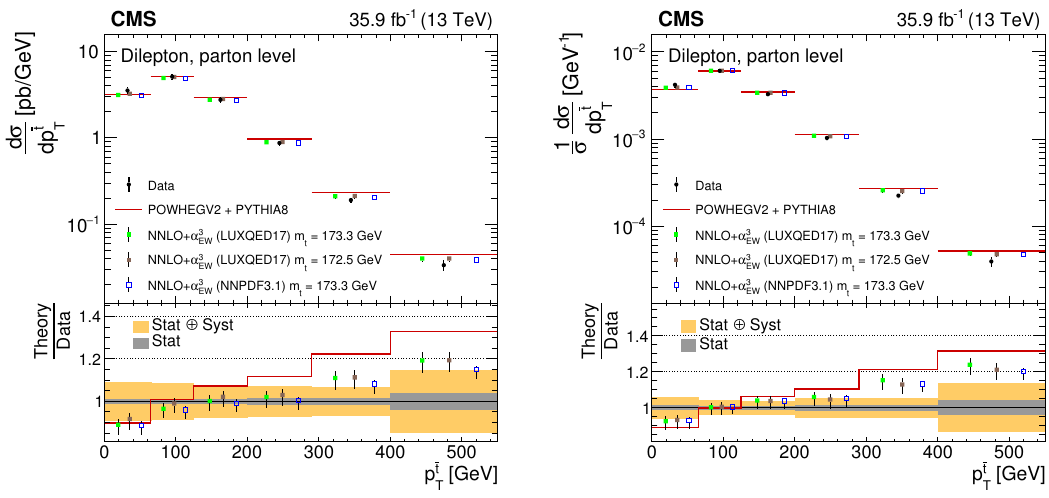
Figure 7 . The di(cid:11)erential tt production cross sections at the parton level in the full phase space as a function of p t are shown for the data ((cid:12)lled circles), the theoretical predictions with beyond-NLO T precision (other points) and the prediction from powheg + pythia (solid line). The vertical lines on the (cid:12)lled circles and other points indicate the total uncertainty in the data and theoretical predic- tions, respectively. The left and right plots correspond to absolute and normalised measurements, respectively. The lower panel in each plot shows the ratios of the theoretical predictions to the data. The dark and light bands show the relative statistical and total uncertainties in the data, respectively.